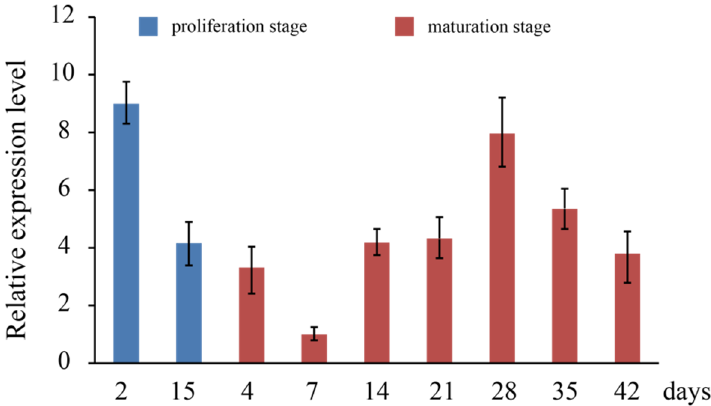
Figure 4. Expression pattern of LaCDKB1;2 during L. kaempferi somatic embryogenesis. Culture line S287, grown in a proliferation medium for 2 or 15 days and in a maturation medium for 4, 7, 14, 21, 28, 35, or 42 days, was harvested for qRT-PCR, with LaEF1A1 used as the internal control. Data are presented as the mean ± SE.